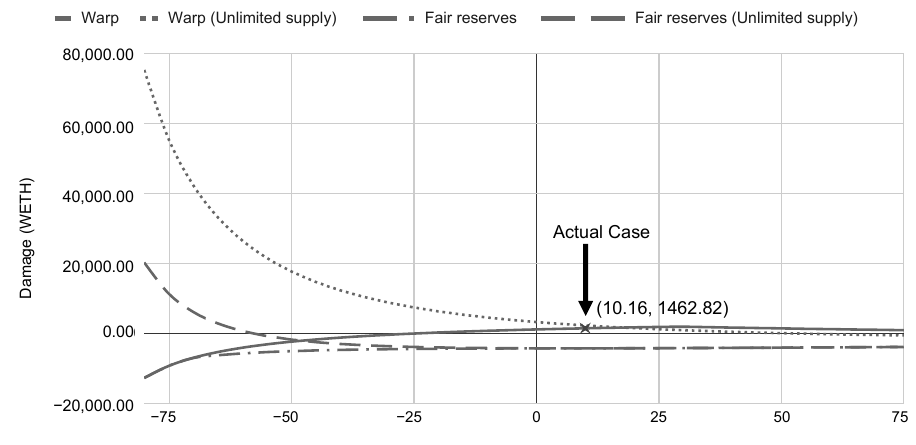
Figure 5. Dynamic market